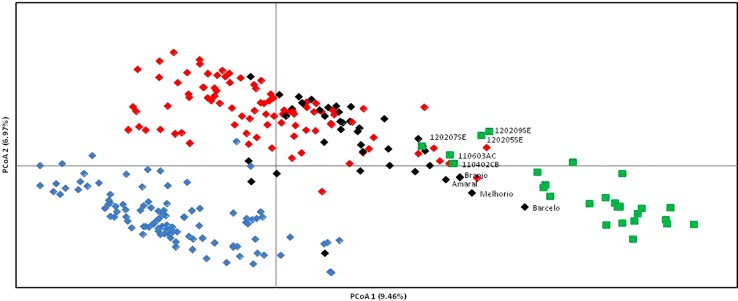
Plot of Portuguese Vitis vinifera, wild vines (green squares), and grapevine varieties (black, blue, and red diamonds) from a Principal Coordinate Analysis based on 231 single nucleotide polymorphism (SNP) markers and via covariance matrix with data standardization. Only wild and cultivated grapevines in intermediate positions are labeled. To facilitate the comparison with Figure 2 the varieties are colored according to their position in Figure 2 (red, black and blue for cluster I, II, and III respectively).